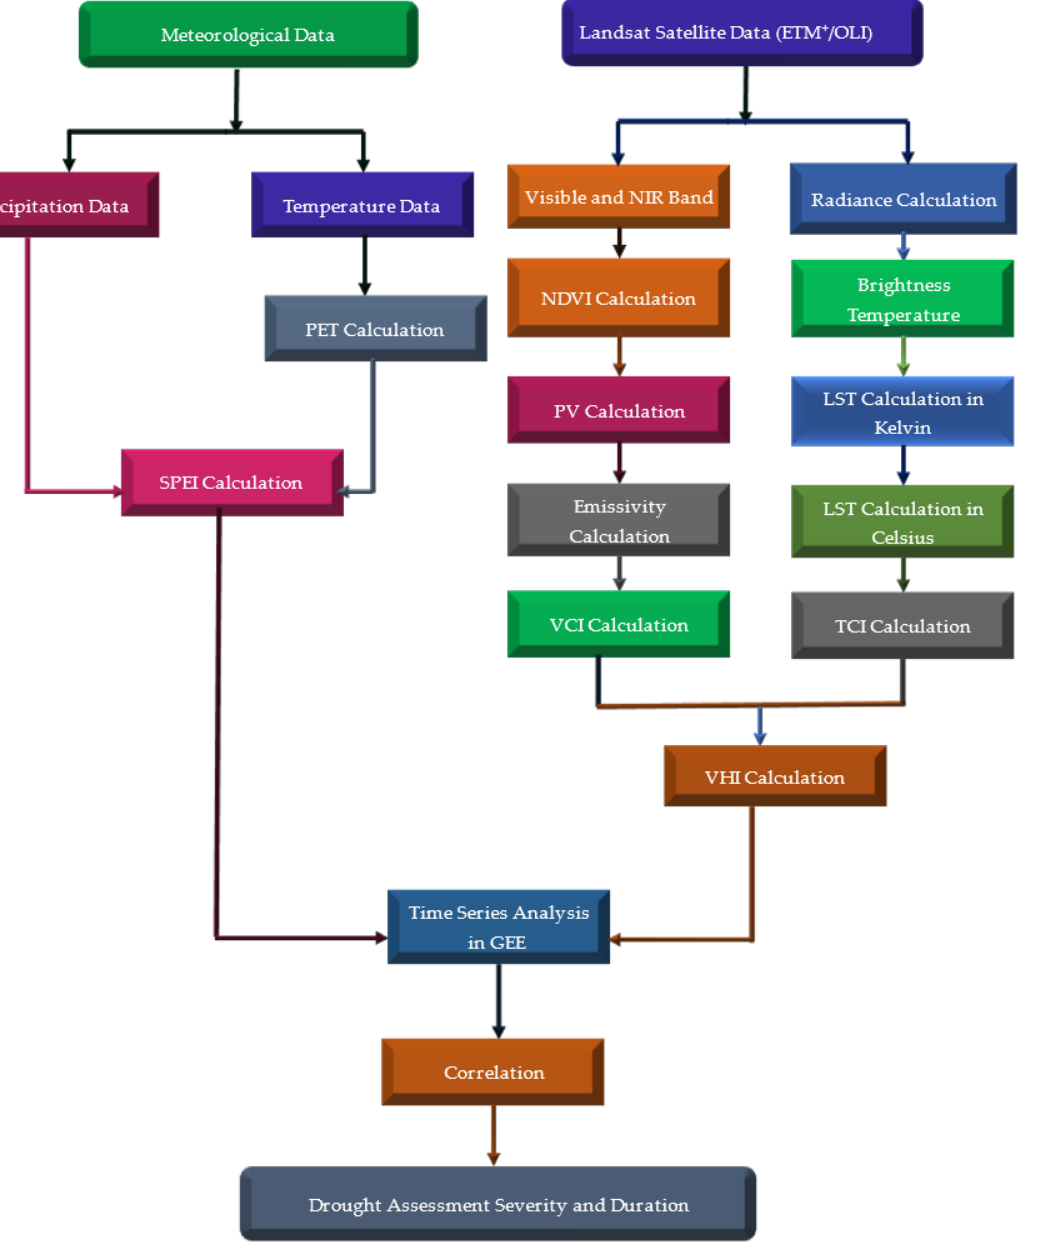
Figure 2 . Methodological framework used in this study. Figure 2. Methodological framework used in this